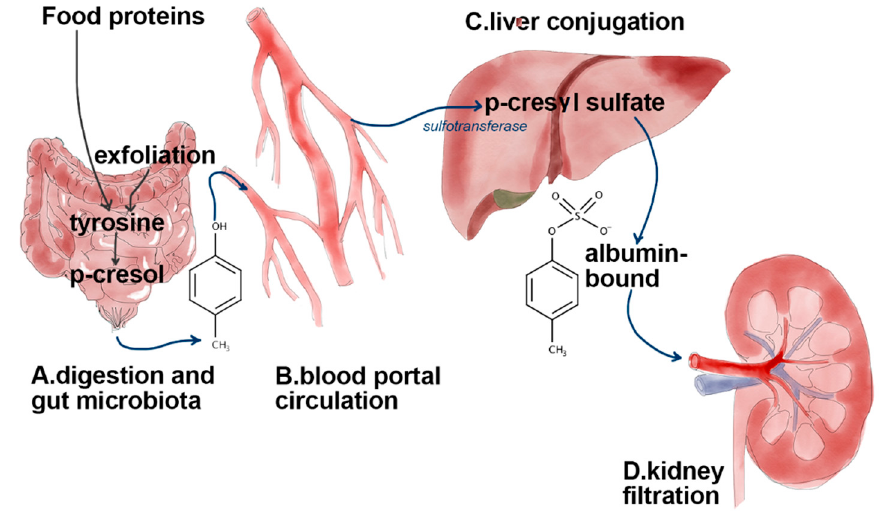
Figure 1. Graphical overview of biochemical transformation of tyrosine coming from food proteins and cellular exfoliation in gut by Clostridium difficile. Through portal circulation, p -cresol reaches the liver where it is bio-transformed by sulfotransferase into p -cresyl sulfate. In healthy persons, more than 99% of p CS is bound to albumin, thus excretion through the kidney occurs primarily via tubular secretion by an organic anion transport system. This binding is decreased in uremic patients.